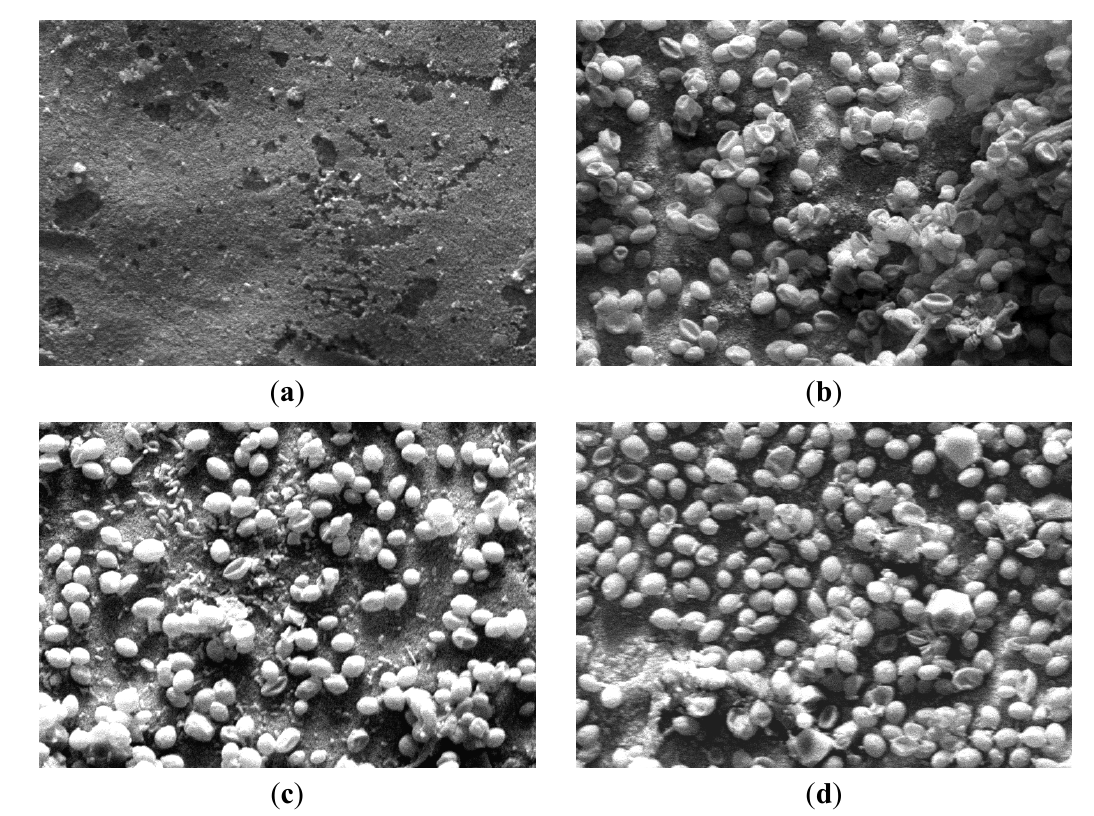
Figure 7. SEM images of the clean membrane and retentates of solutions containing different concentrations of S. cerevisiae and E. coli ( a ) clean membrane; ( b ) S ; ( d ) S 7